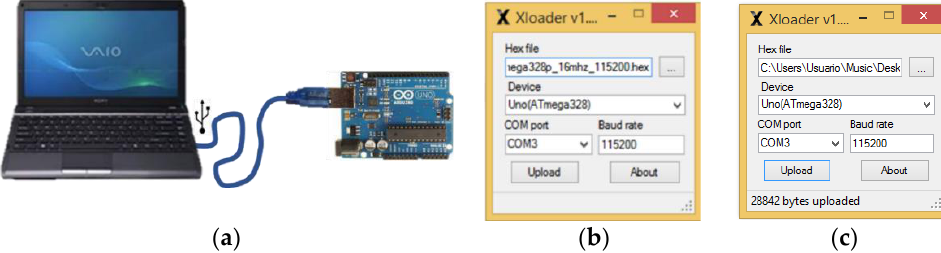
Figure 8. Procedure for transferring the GRBL firmware in Arduino UNO. ( a ) connect Arduino UNO, ( b ) Configure XLoader and ( c ) Load GRBL firmware on Arduino.